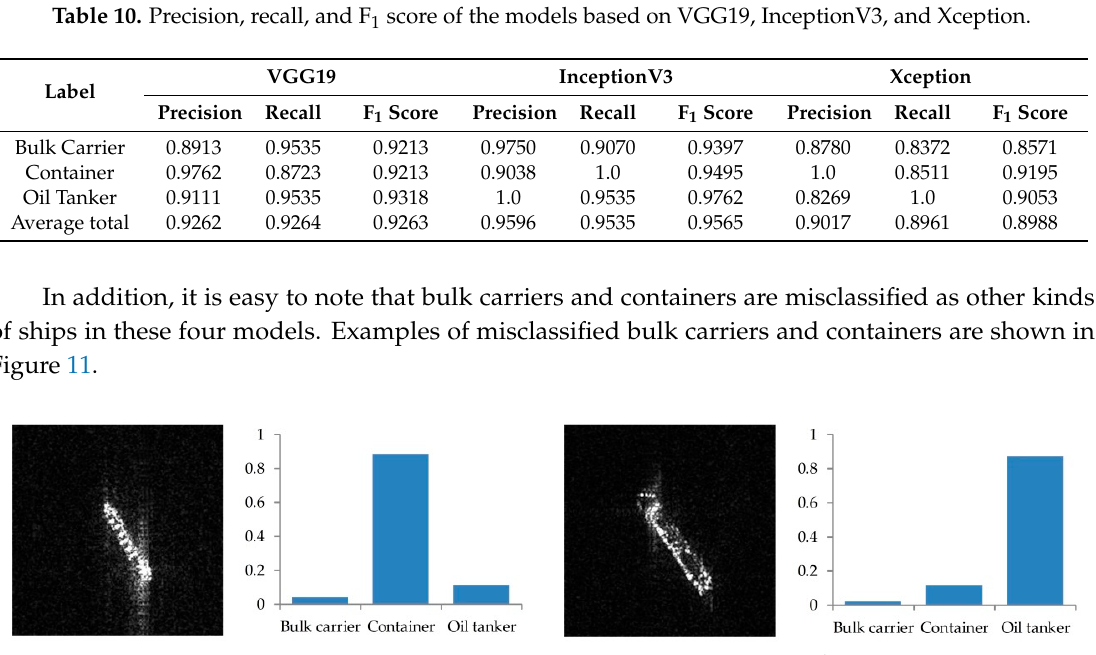
Table 8. Classification accuracies and training time of the four models.